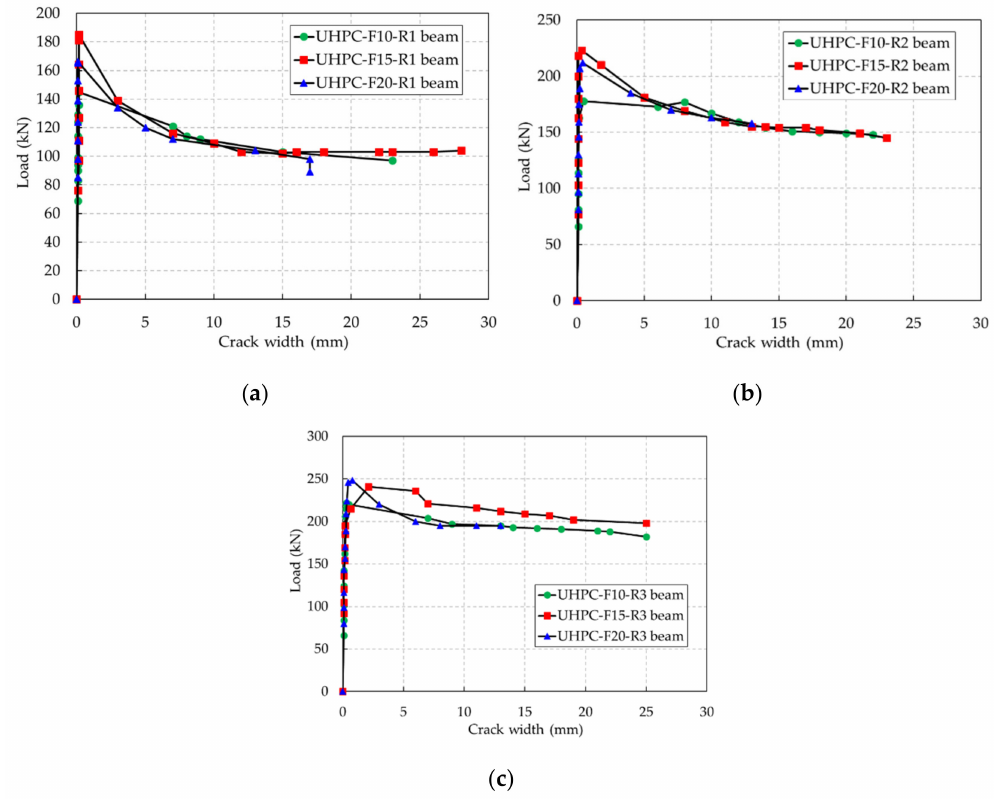
Figure 9. E ff ect of the steel fiber content on the evolution of the crack width. ( a ) Rebar ratio of 0.79%, ( b ) rebar ratio of 1.18%, ( c ) rebar ratio of 1.58%. The failure of the HSC beams occurred abruptly by concrete crushing in the compressive